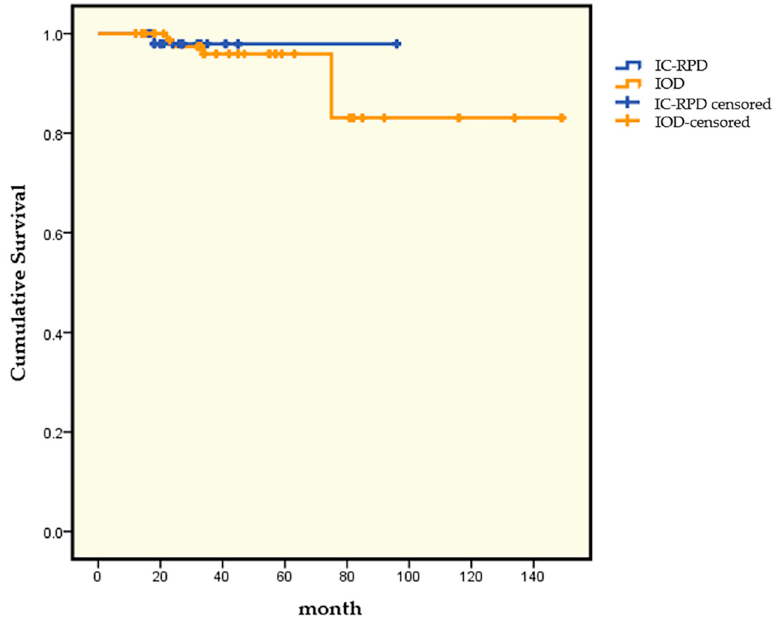
Figure 2. Kaplan–Meier survival curve according to treatment modality (IC-RPD vs. IOD).